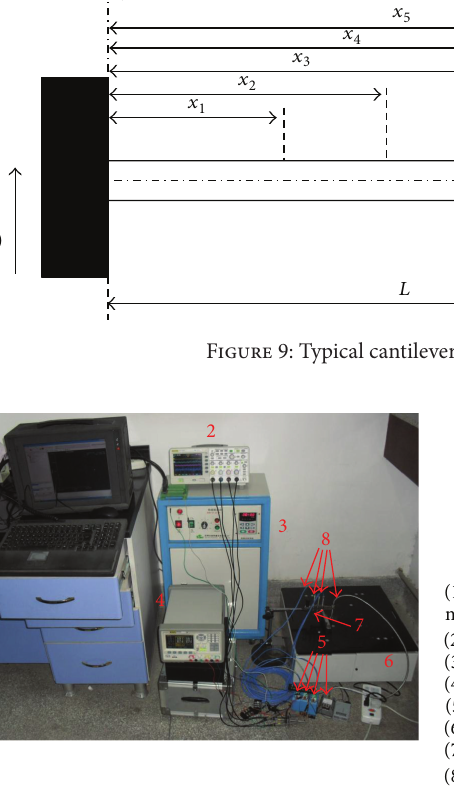
Figure 10: Complete experimental